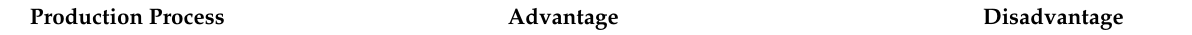
Table 2. Advantages and disadvantages of main biodiesel production processes